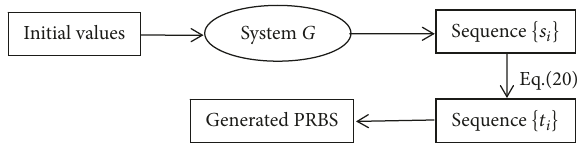
Figure 5: The main frame of new PRBG.